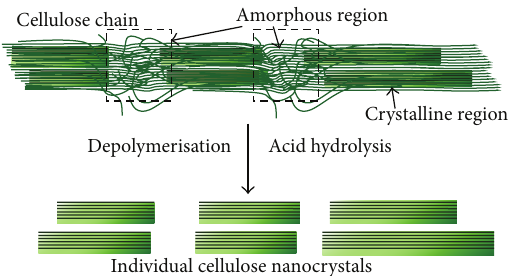
Figure 8: Depolymerisation of cellulose to